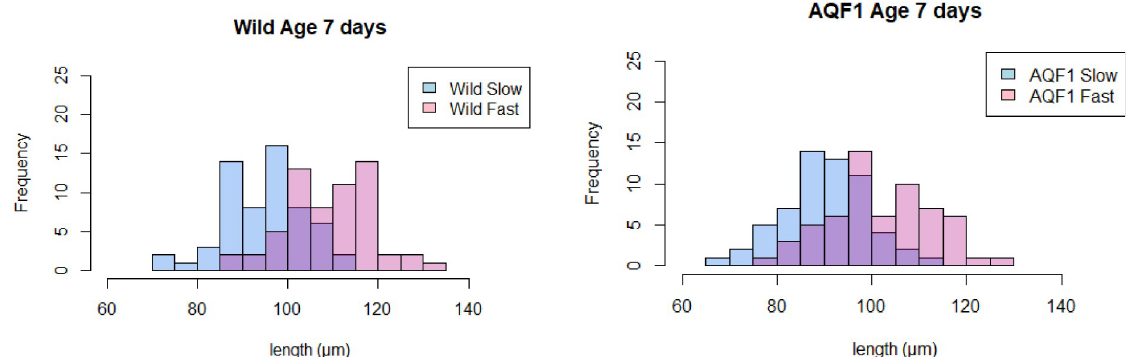
Fig 1. Length distributions of larvae at the start of the starvation experiment (T = 0; Age = 7 days). Pink bars represent the fast-growing larvae and blue bars represent slow growing larvae for each line (wild and AQF1). A total of 60 larvae were measured for each cohort (Wild/ Fast, Wild/Slow, AQF1/Fast, AQF1/Slow). The purple region indicates the overlap in size between the two groups for each line.